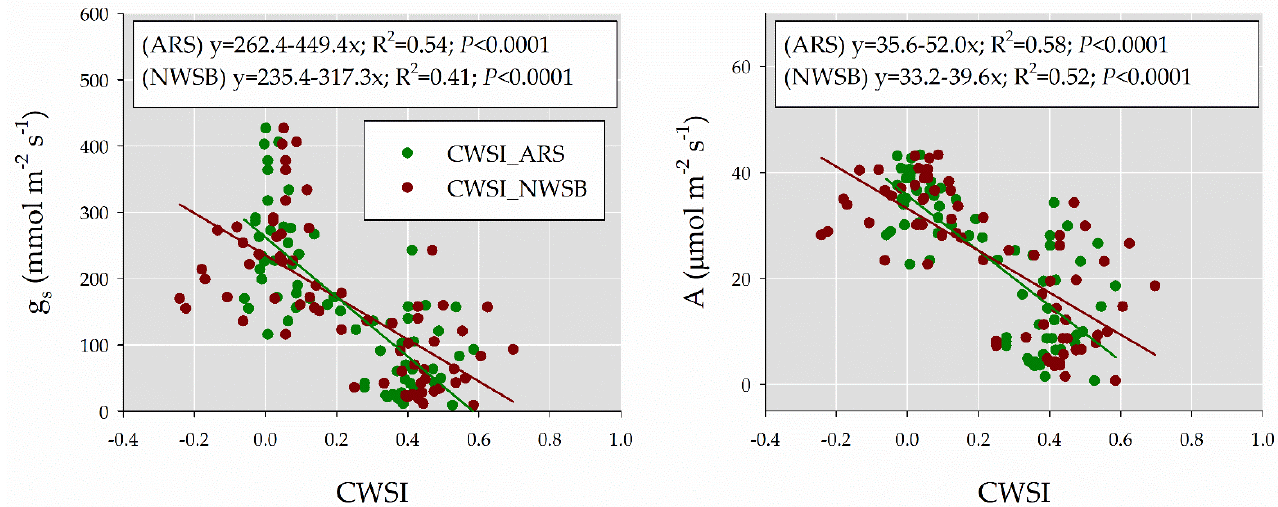
Figure 12. Relationship between stomatal conductance (g s ) (left panel) and leaf photosynthesis (A) (right panel) with ARS-based and NWSB-based crop water stress index (CWSI). In both panels, each point represents a single maize breeding plot and sampling date. The straight lines represent the best-fit regression